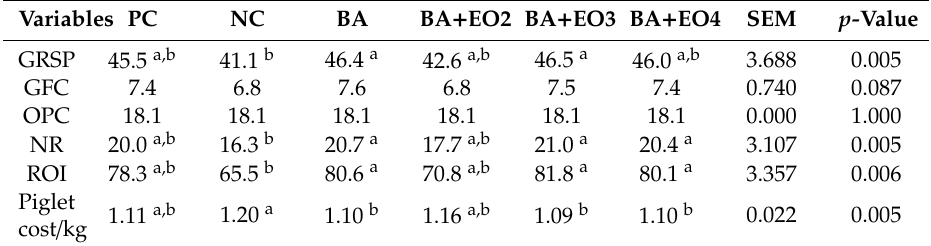
Table 9. Economic evaluation of using di ff erent experimental